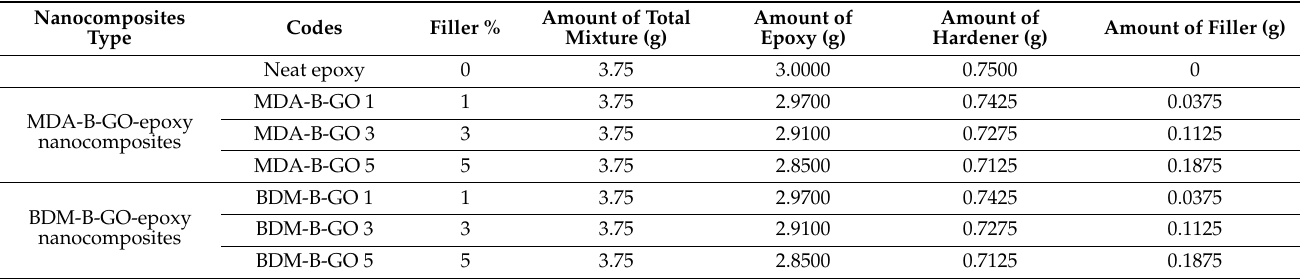
Table 1. Codes and amounts of fillers in epoxy